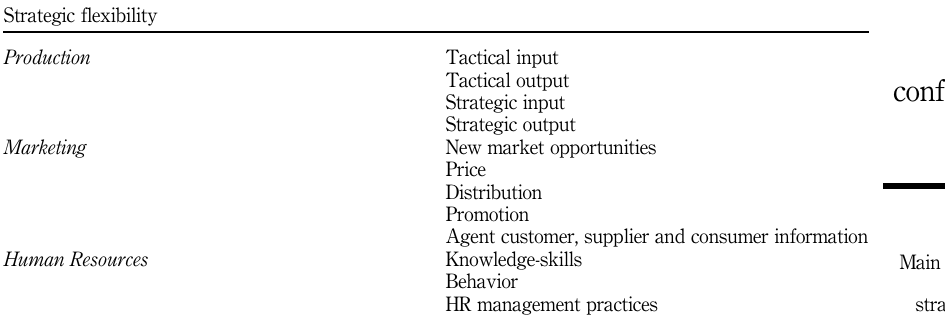
Table I. Main and subsidiary dimensions of strategic flexibility